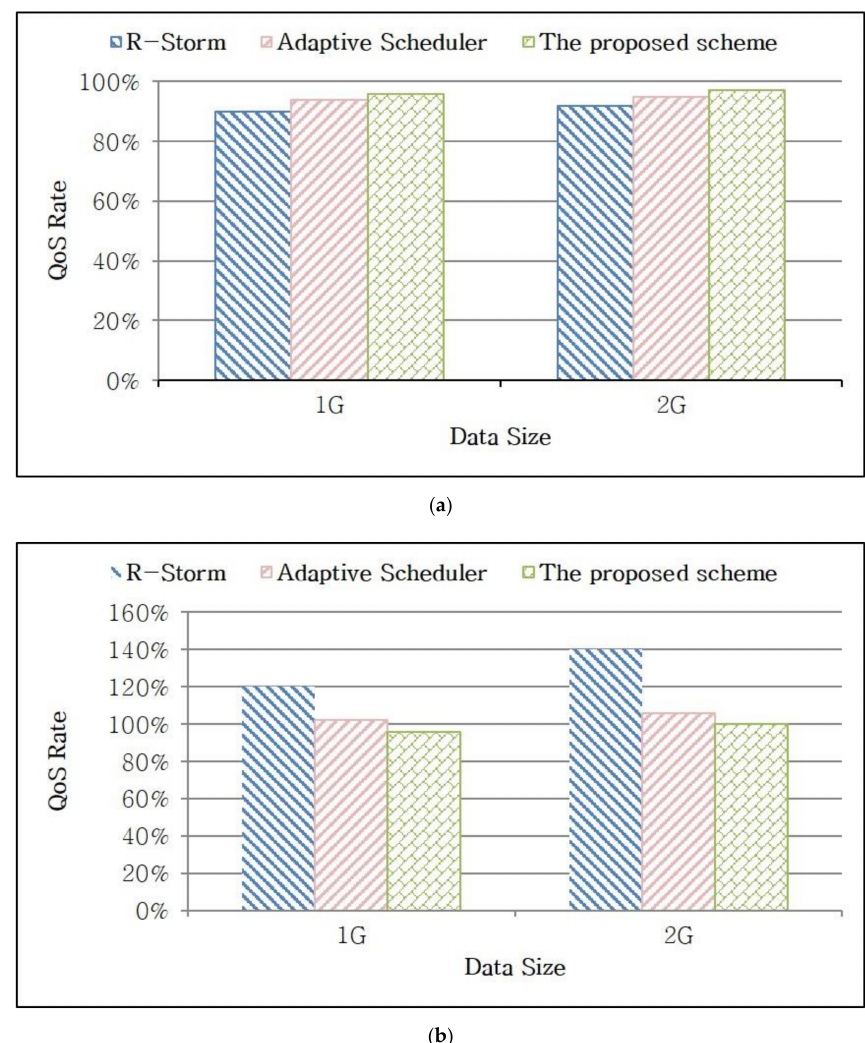
Figure 10. QoS rates based on data sizes. ( a ) QoS rate for simple query; ( b ) QoS rate for complex